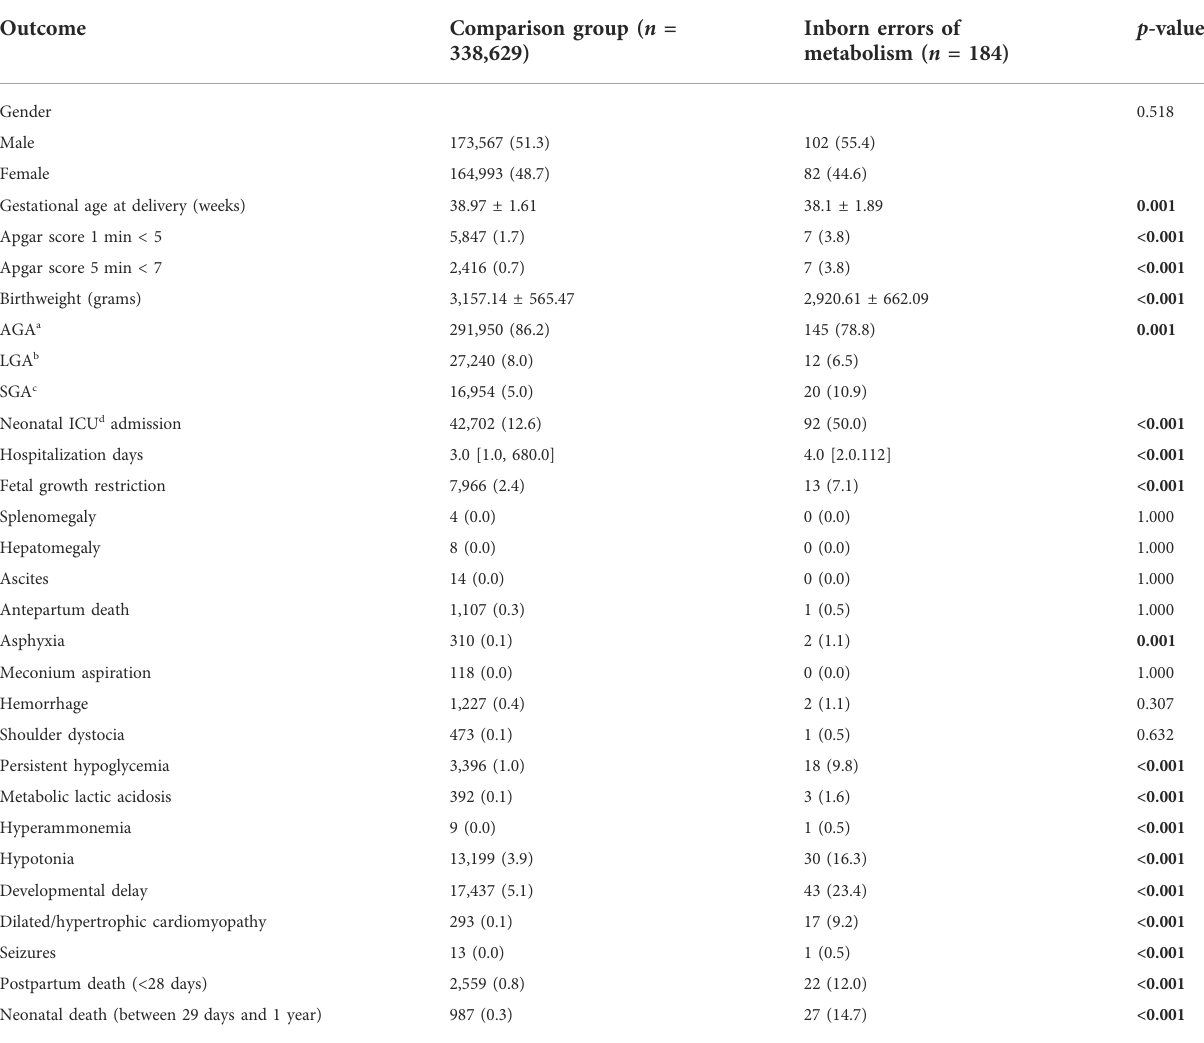
TABLE 3 Fetal and neonatal